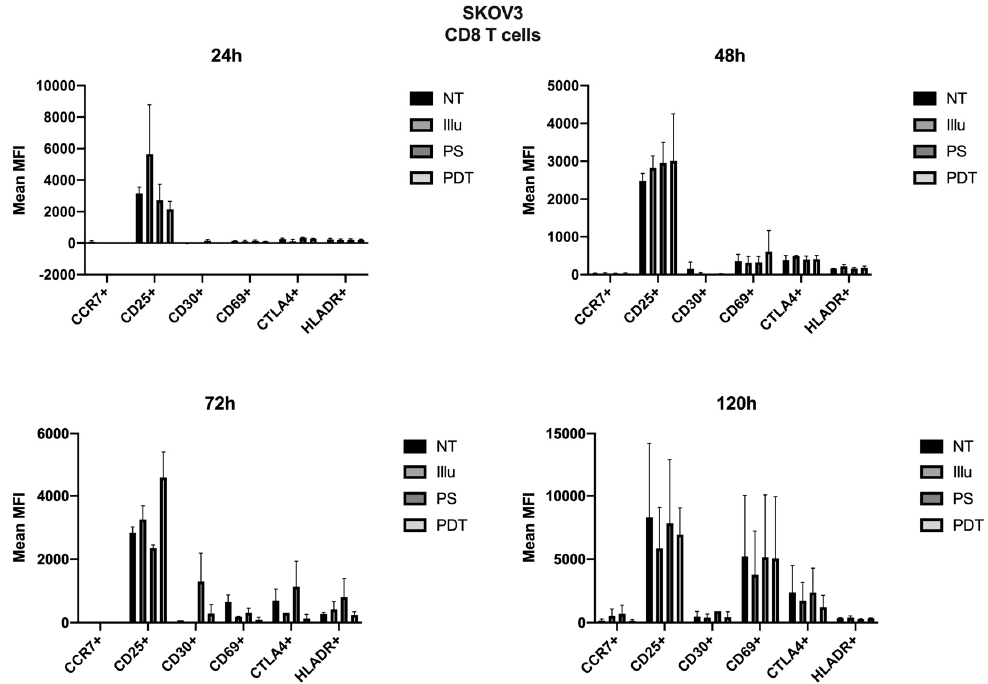
Figure 9. FACS analysis of activating markers of CD4 + T cells cultured with conditioned media of SKOV3 cells at 24 h, 48 h, 72 h, and 120 h. NT: non-treated, PS: Photosensitizer only, illu: illumination only, PDT: illumination in the presence of PS, ML10: the raw culture media of PBMC. Results are expressed in Mean of MFI ( n = 3 independent donors).